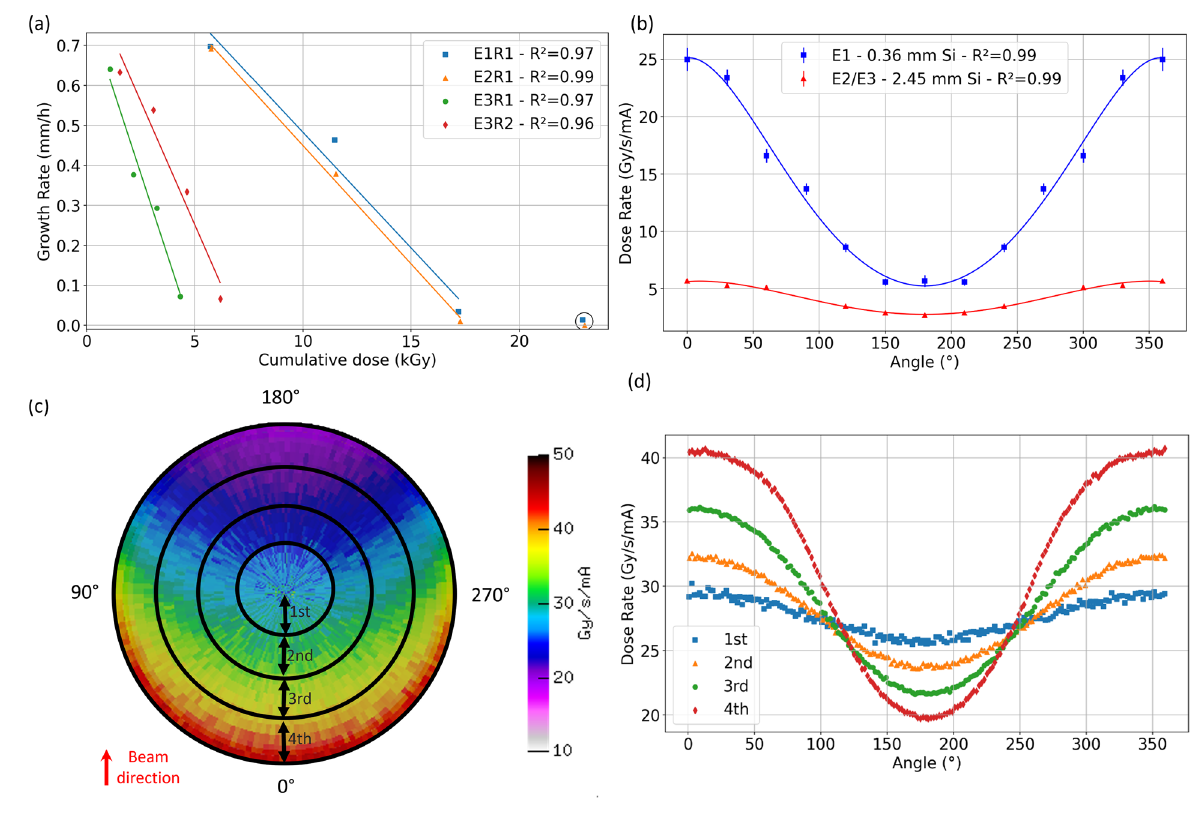
Figure 5. ( a ) Root growth rate as a function of modeled cumulative absorbed dose on the root for each experiment, where consecutive data points from left to right on each curve represent the sequence of timepoints (TP1, TP2, TP3, and TP4). The circled points were not included in the linear regressions because in these curves the roots had essentially stopped growing between TP2 and TP3. ( b ) Modeled effect of rotation angle and Si-filter thickness on the dose rate (normalized by current) on a root positioned along the pipet-tip wall, where 0° represents the angle between the vector of the incoming beam and a vector projected from the root to the center of the sample (see Fig. 2c). A 0.36 mm filter was used in E1, and a 2.45 mm filter was used in E2 and E3. ( c ) Modeled dose rate distributions across incremental cylindrical volumes of a soil sample irradiated with